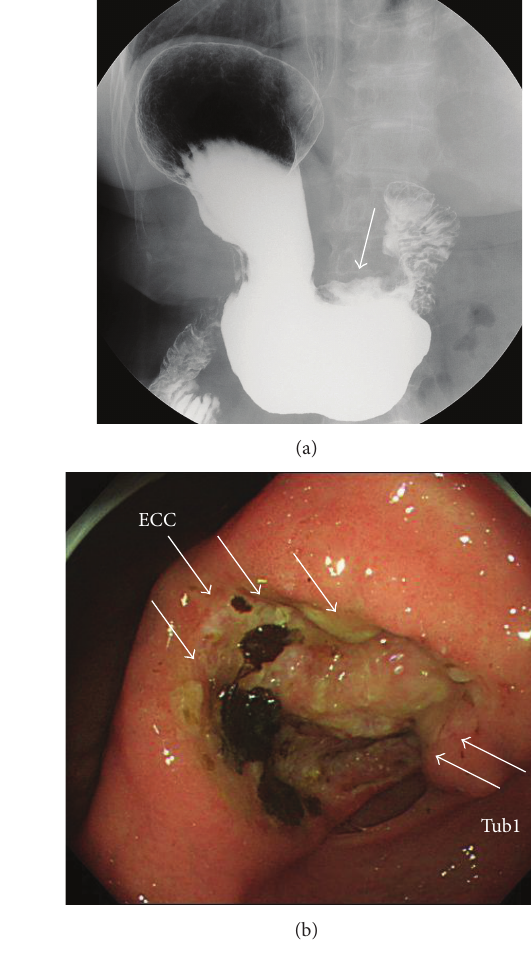
Figure 1: Upper gastrointestinal series revealed a 5cm ulcerative lesion with irregular margins and elevated distinct borders from the angle to the pyloric ring (a). Gastroendoscopy revealed a Borrmann type 2 tumor, extending from the angle to the antrum of the lesser curvature (b). The tumor comprised two different parts: ulcers with severe invasiveness and smooth protrusion from the endocrine cells and well-differentiated adenocarcinoma cells, as revealed by specimens biopsied under